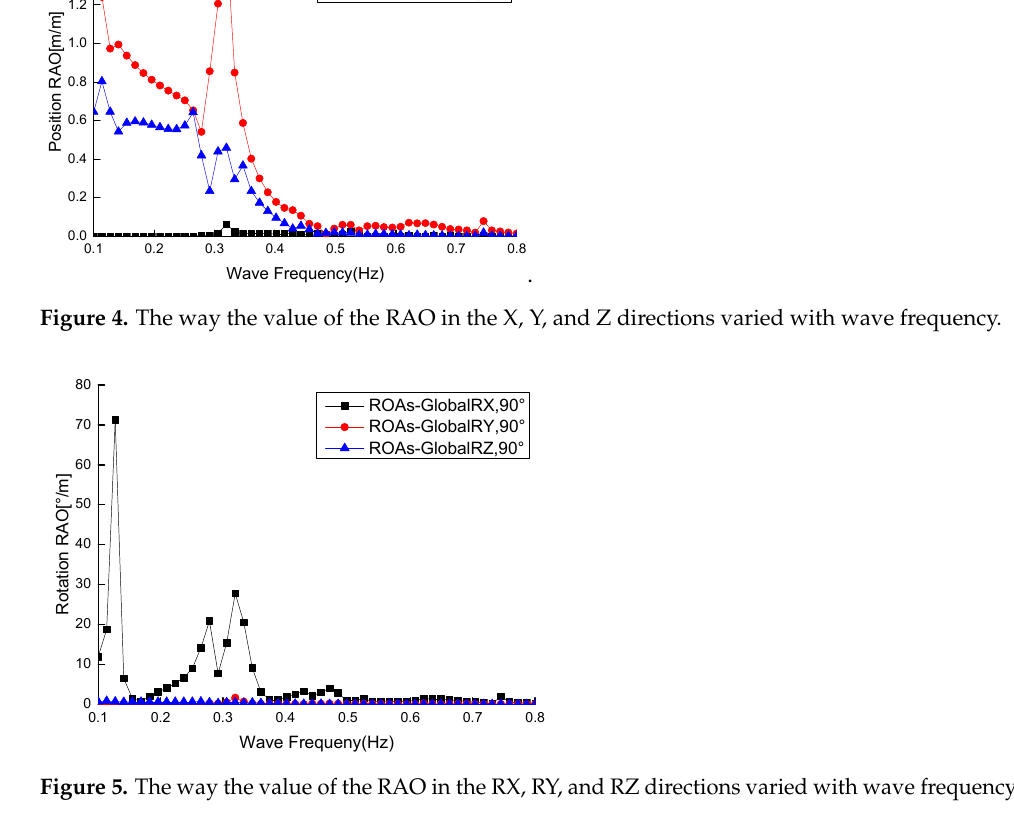
Figure 4. The way the value of the RAO in the X, Y, and Z directions varied with wave frequency.